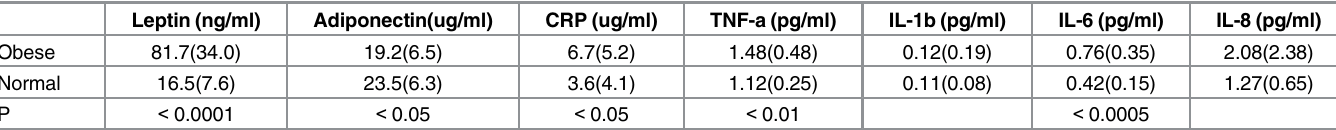
Twelve (12) obese and 12 normal weight subjects produced adequate sputum samples (see methods) for analysis of cell differentials on the training and both exposure days. Both groups showed a significant ozone-induced increase in sputum neutrophil concentration and as % of total recovered cells, Table 6. No differences in neutrophil concentrations were observed between the training and air exposure days, i.e., a comparison of no-exercise to exercise base- lines. There were also no differences in sputum neutrophils between groups for either the train visit (no exercise) or the two exposures. Among the measured cytokines in sputum there were no differences by weight group and only IL-6 showed any evidence of ozone-induced increases in either group. There was no exercise effect on sputum IL-6 in either group (i.e. train vs. air study days) but there was a significant increase for ozone vs. air exposure in the normal weight group (Table 6). There was also a trend for an increase in the obese for ozone vs. air (Table 6, p = 0.11 by Wilcoxon matched pairs signed-rank test). There were no group differences on any exposure/train day, possibly due to the large variability for each group. However, among all subjects post-ozone log (sputum IL-6) and log (sputum neutrophil concentration) were strongly correlated (R = 0.75, p < 0.0001). Average pre-exposure plasma concentrations of cytokines and adipose hormones for obese and normal weight are given in Table 7. Baseline plasma leptin and CRP were respectively about 5 and 2 fold higher in the obese vs. the normal weight subjects (p < 0.0001 and < 0.05). Levels of the fat hormone adiponectin were less in the obese vs. normal weight (p < 0.05) and the cytokines TNF- α and IL-6 were elevated in the obese vs. normal weight (p < 0.01 and p < 0.0005). Plasma IL-6 showed the most significant changes associated with ozone exposure in either group, Fig 1. There was a trend for plasma IL-6 to be acutely increased by exercise (pre- vs. 4 hr post air exposure) only in the obese (p = 0.06) but returned to pre-air exposure levels at 20h post-exposure. In both groups plasma IL-6 was significantly increased by ozone exposure. In the obese group only there was a comparable decrease for pre- vs. post- air and ozone exposures for plasma levels of leptin and TNF-a (p < 0.05), suggesting an exercise or time-of-day effect on levels of these markers in the obese. The complete data set for parameters reported in this manuscript can be found in S1 File. Table 7. Summary (mean and SD) of baseline plasma adipose hormones and chemokines (average of two pre-exposure for each subject). Leptin (ng/ml)